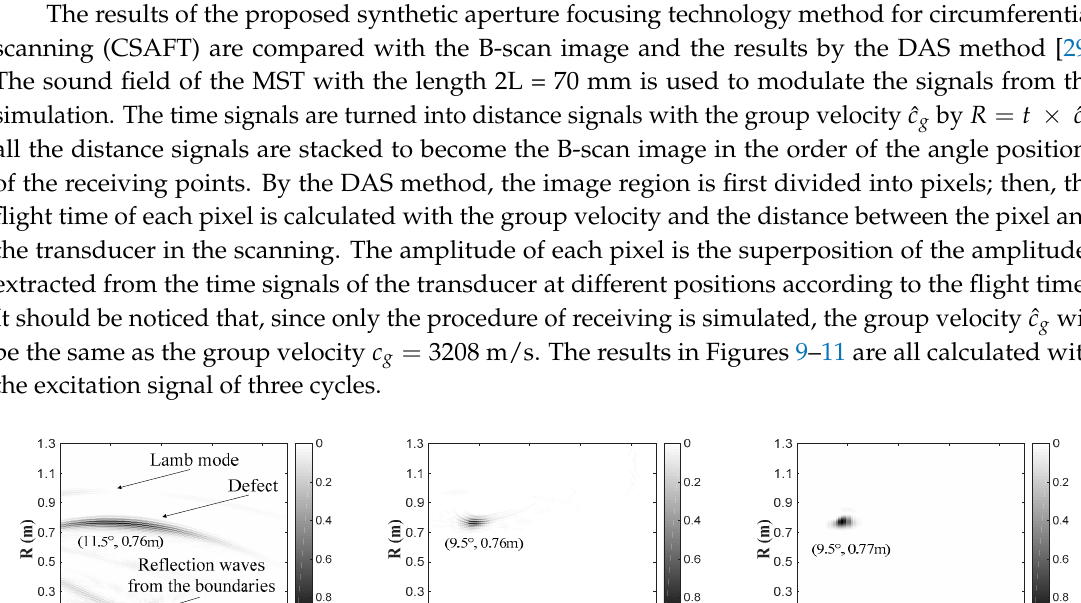
Figure 8. The excitation signals with different cycles and their amplitude spectrums: ( a ) three cycles; ( b ) five cycles; ( c ) seven cycles; ( d ) nine cycles. The half-decline frequency bandwidth of the signals is marked.